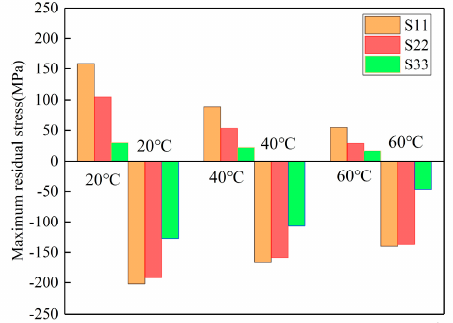
Figure 10. Maximum residual stresses of W / 2024Al composite blocks quenched by water of di ff erent temperatures.